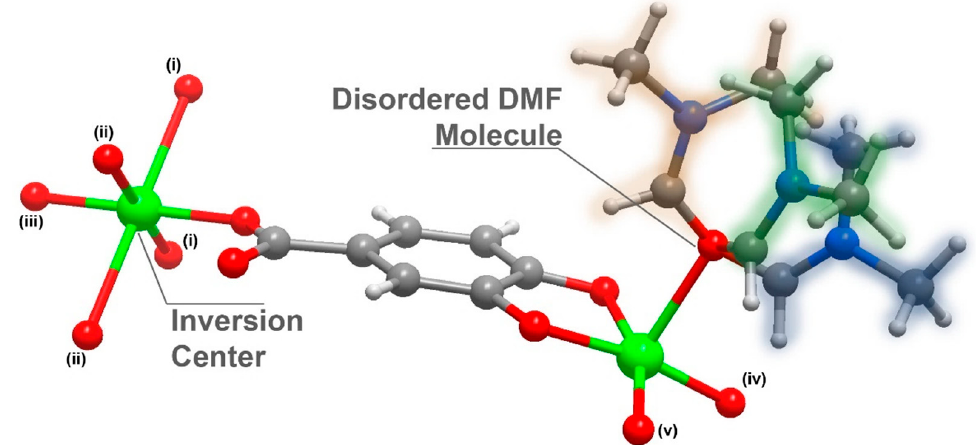
Figure 1. Schematic representation of the asymmetric unit in [Cu 3 L 2 (DMF) 2 ] n ( 1 ), emphasizing the disorder present in the coordinated DMF molecule and the inversion centre present in the Cu2 atom. Metal centre coordination environments were generated using the symmetry transformation (i) x + 3/2, y + 1/2, − z + 1/2; (ii) x + 1/2, − y + 3/2, z + 1/2; (iii) − x + 2, − y + 2, − z + 1; (iv) x − 1/2, − y + 3/2, z − 1/2; (v) – x + 1, y, − z + 1/.